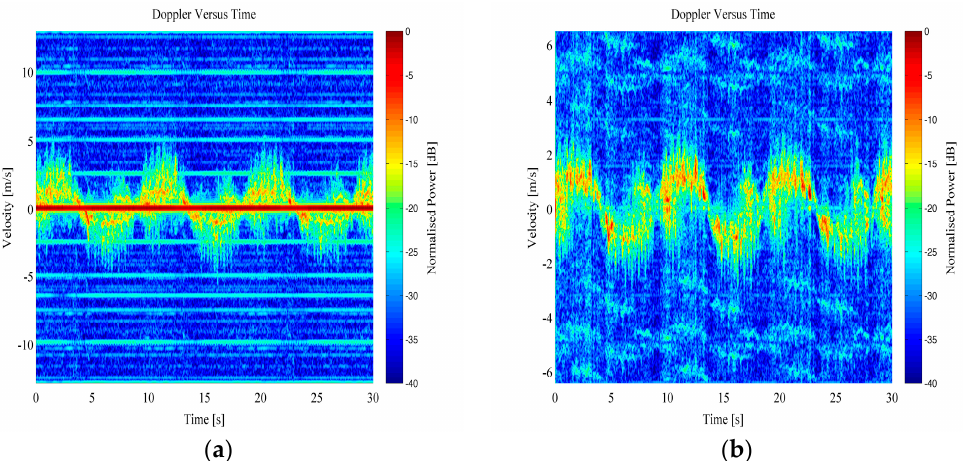
Figure 8. Example Doppler-time spectrogram from a person walking carrying a bag in both hands: ( a ) RTI micro-Doppler; ( b ) MTI micro-Doppler.